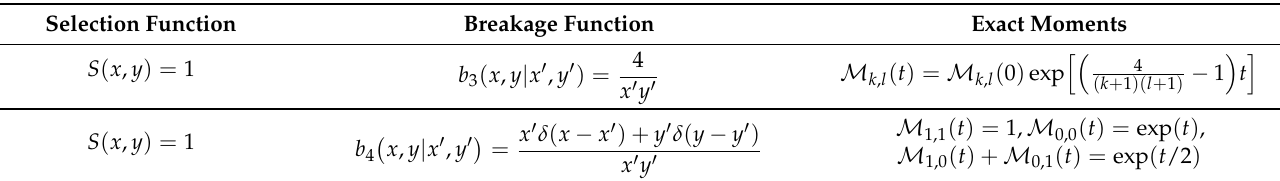
Table 6. Exact moment functions for S = 1 and breakage functions b 3 , b 4 . Selection Function Breakage Function Exact Moments